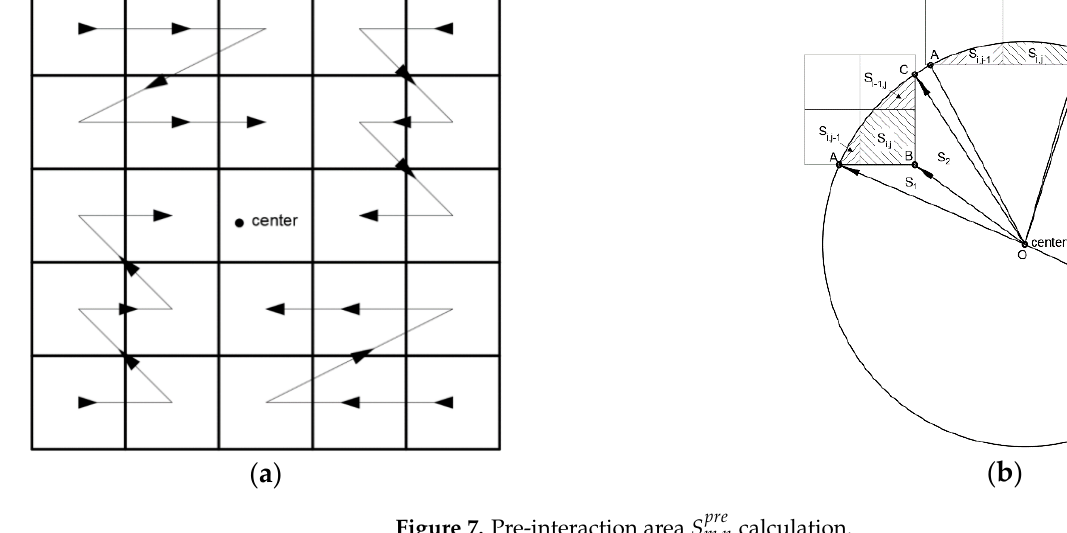
Figure 7. pre-interaction area 𝑆 𝑚,𝑛𝑝𝑟𝑒 calculation. Figure 7. Pre-interaction area S pre m , n